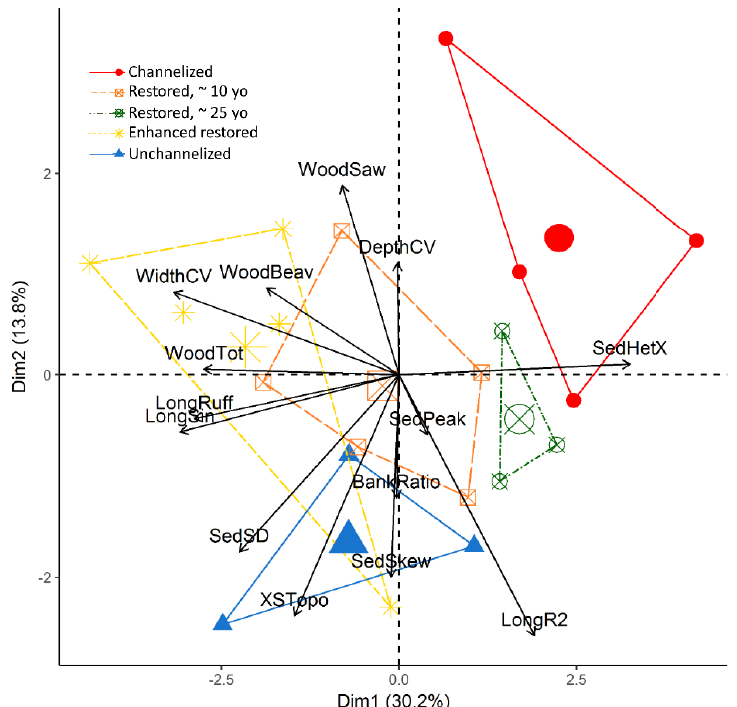
Figure 2. First two dimensions (Dim) of the PCA ordination of a reduced set of complexity metrics (14) with the percent of the variation they described in parentheses. Each point represents a single reach and different symbols show the restoration status of a given reach. We have delineated the extent of the range in variation for each status with different line patterns and colors that match the color of the points. The oversized symbol marks the average position of the sites of a given status in ordination space. Arrows show strength and direction of geomorphic complexity metrics as they relate to the sites.